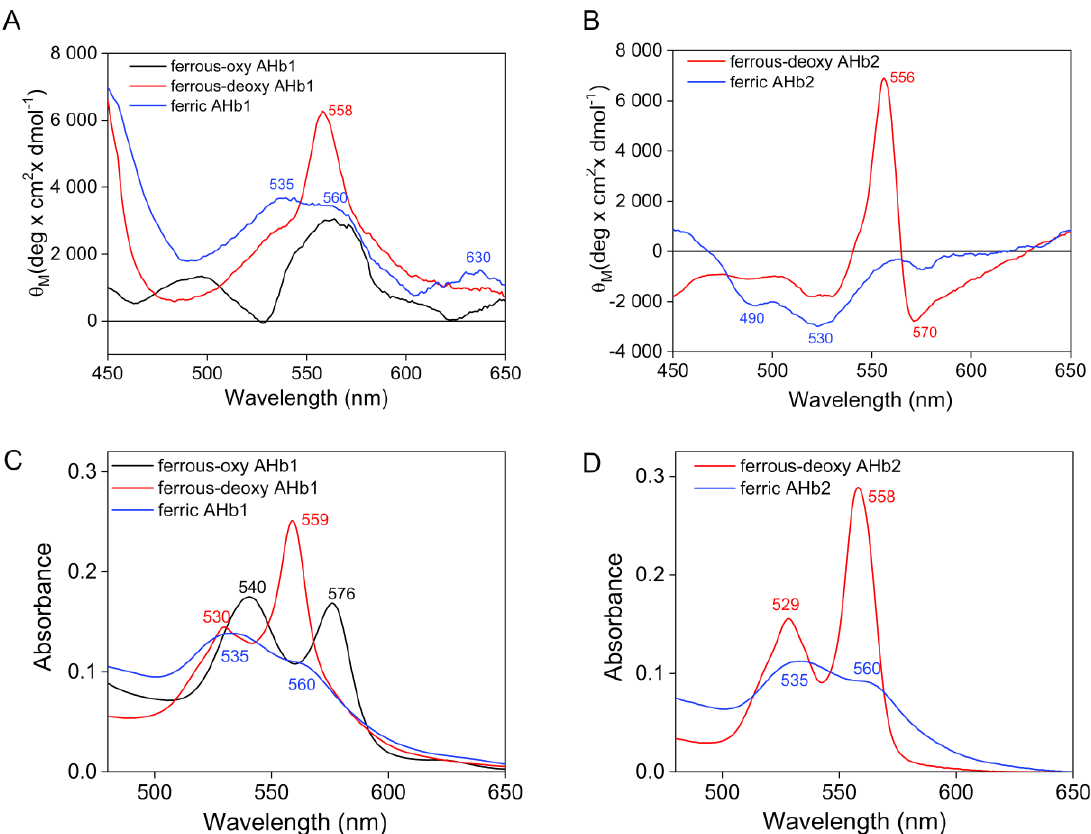
Figure 6. Circular dichroism ( A , B ) and absorption ( C , D ) spectra of AHb1 and AHb2 in the visible region. CD spectra ( A , B ) were recorded using 120 μ M (AHb1) and 140 μ M (AHb2) heme in 10 mM Tris-HCl buffer, pH 8.0. For absorbance measurements ( C , D ), protein concentrations were 20 µM heme proteins in 20 mM Tris-HCl buffer, pH 8.0.